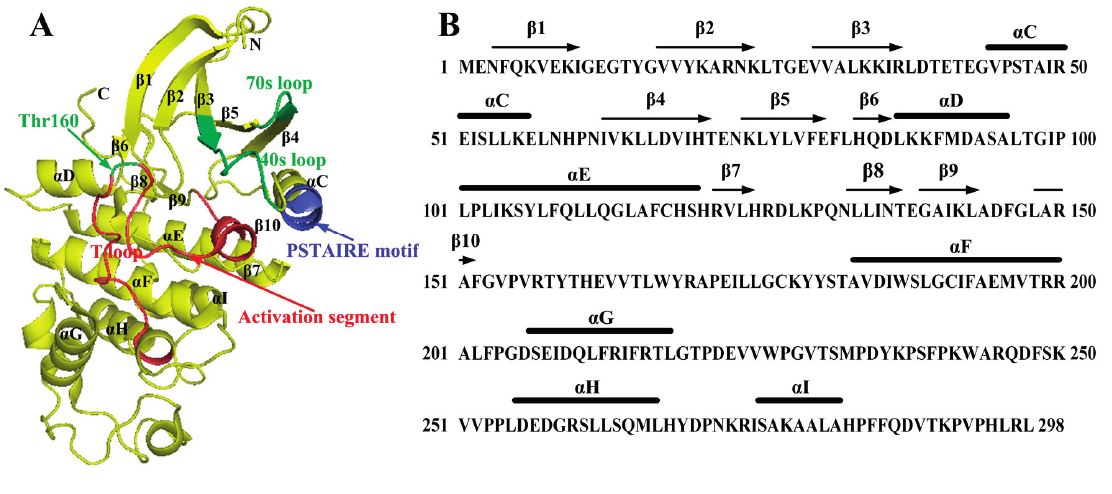
Figure 2. The structure of monomeric CDK2. ( A ) Schematic diagram showing the structure of monomeric CDK2 using coordinates 4KD1. Secondary structural elements and the important fragments are labeled; ( B ) Sequences of CDK2 showing secondary structural